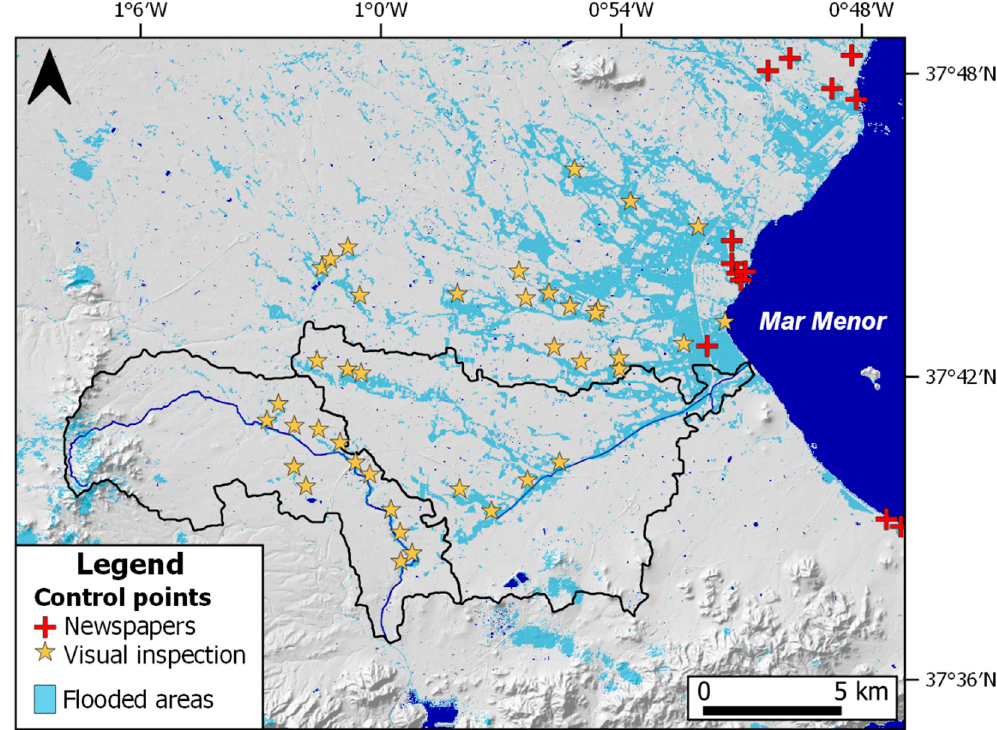
Figure 6. Control points to determine flood threshold. Data were based on newspaper articles and visual inspection from RGB bands of Sentinel-2 satellite images.